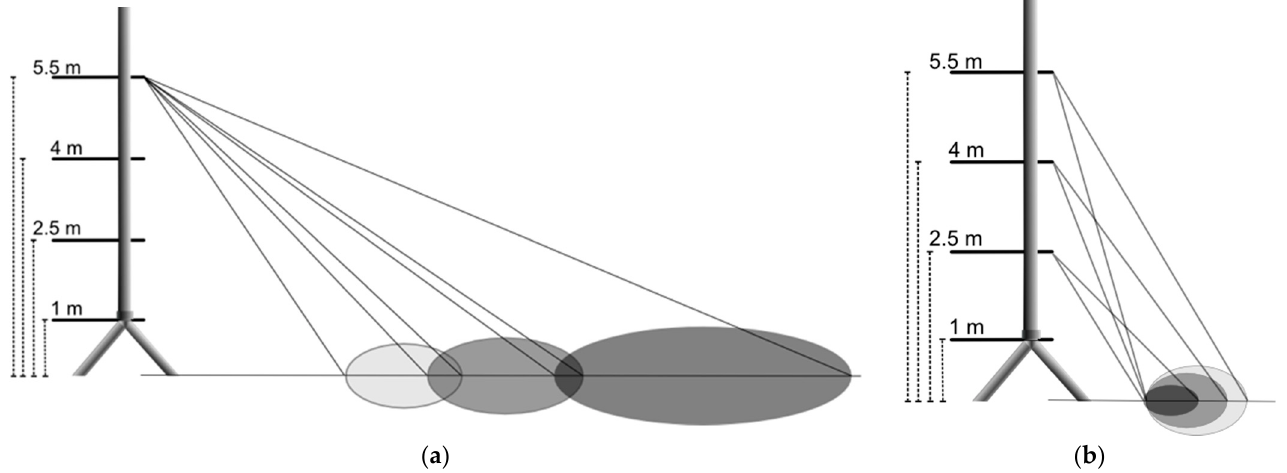
Figure 5. Footprints of reflectance and radiative temperature measurements for ( a ) a fixed height and varying viewing zenith angles, or ( b ) a fixed viewing zenith angle and different heights. Table 3. Areas of influence of the Apogee TM sensor for an 18.4° viewing angle and ASD TM sensor for a 25° viewing angle with three different heights (parameters are described in Figure 3).